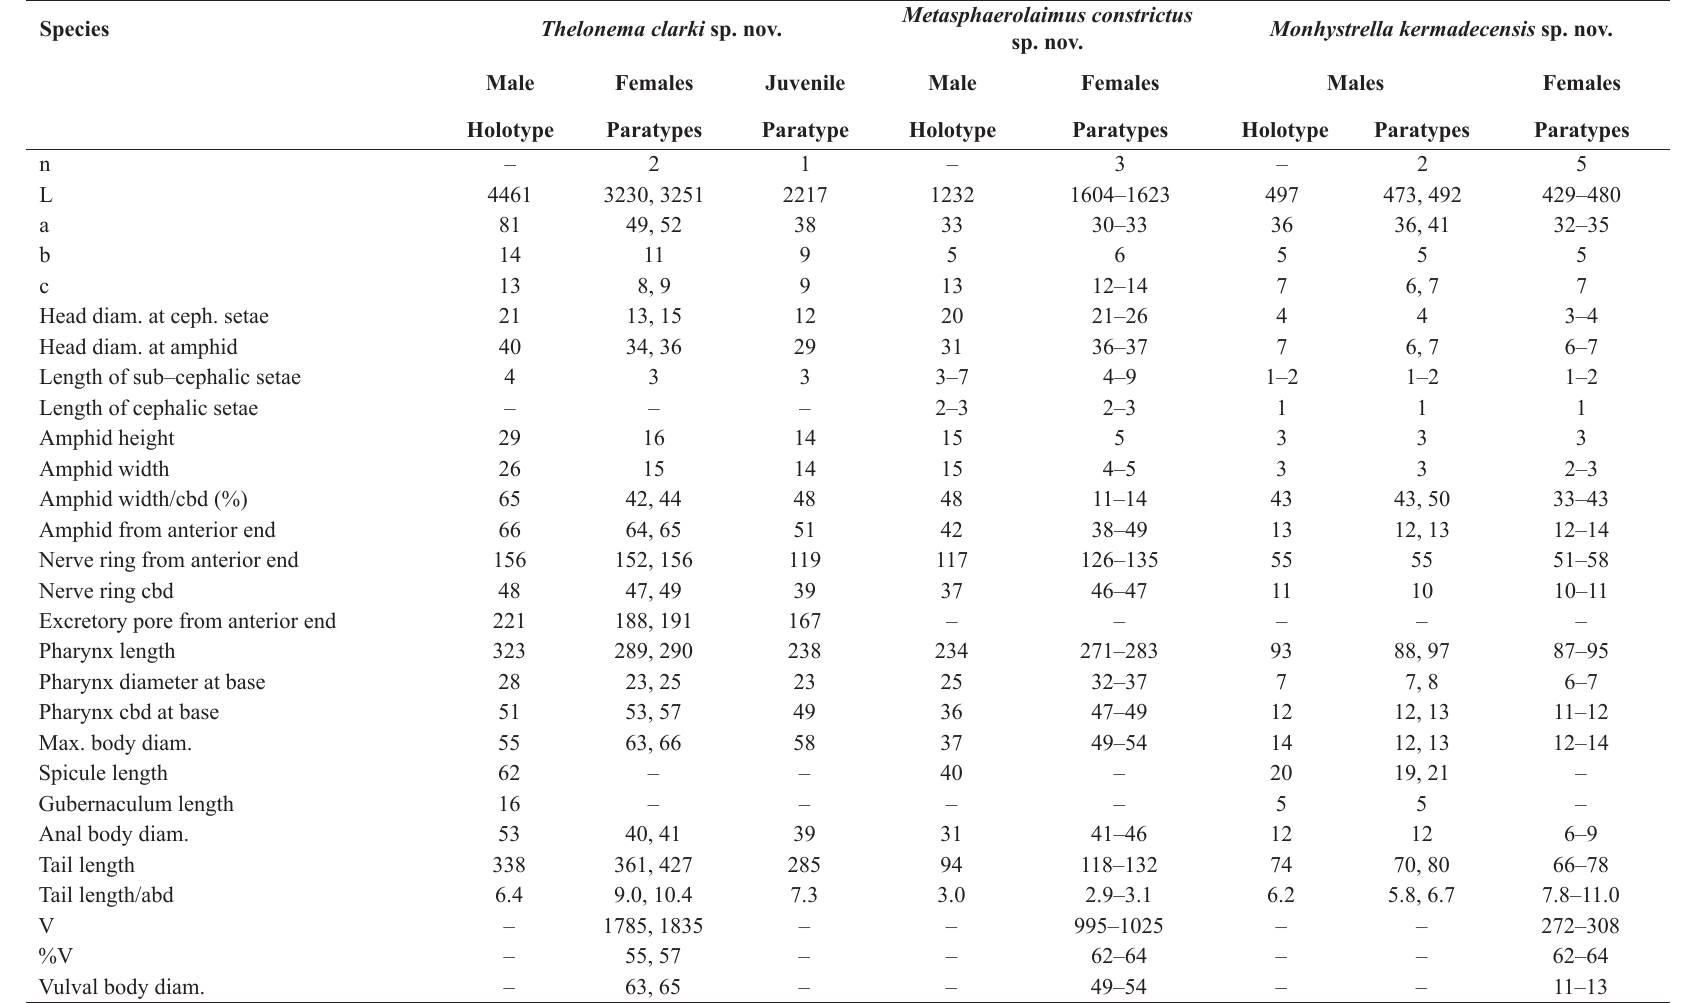
Table 1 . Morphometrics (µm) of Thelonema clarki sp. nov., Metasphaerolaimus constrictus sp. nov., and Monhystrella kermadecensis sp. nov. (n, number of specimens; L, body length; V, vulva distance from anterior end of